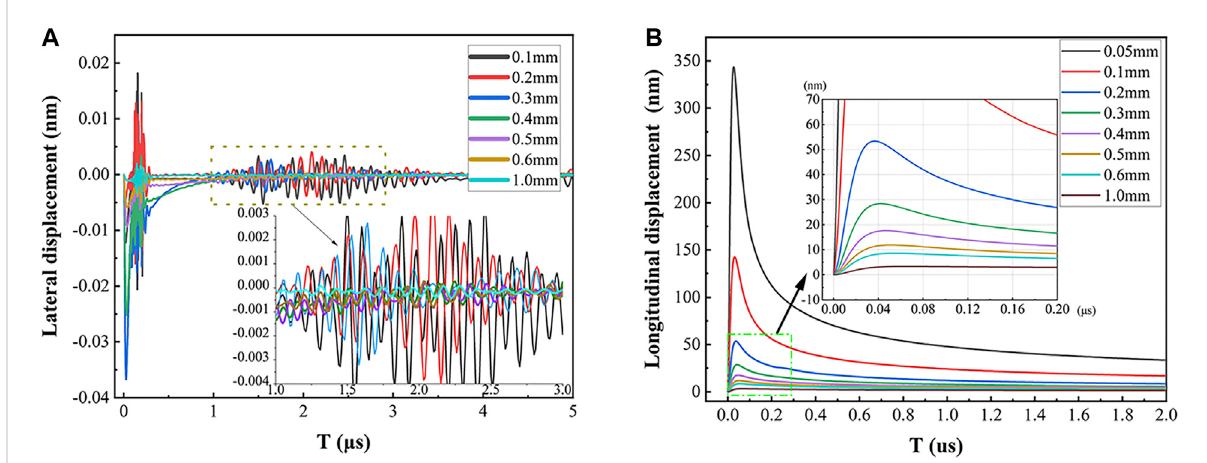
FIGURE 5 Stress displacement: (A) X displacement in the lateral direction; (B) Y displacement in the longitudinal